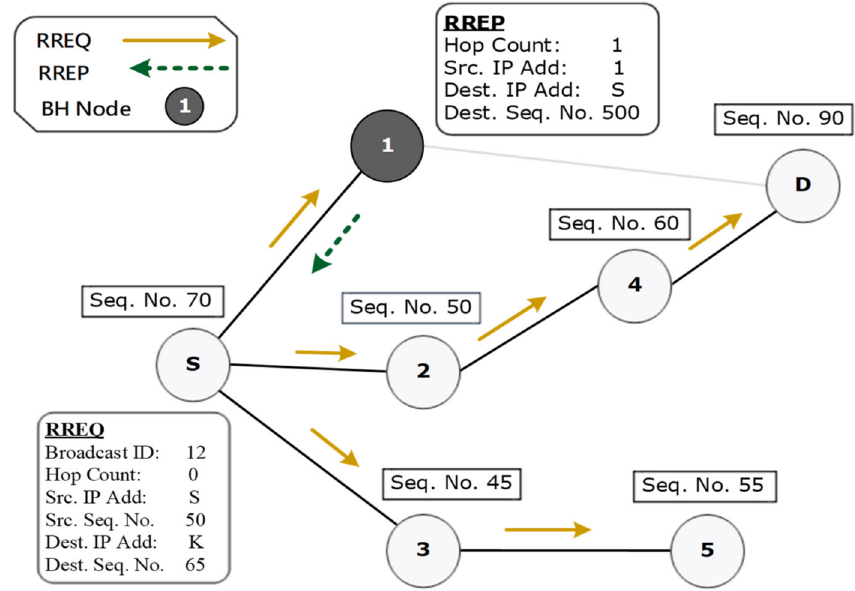
Figure 7. A scenario demonstrating the prevention phase.